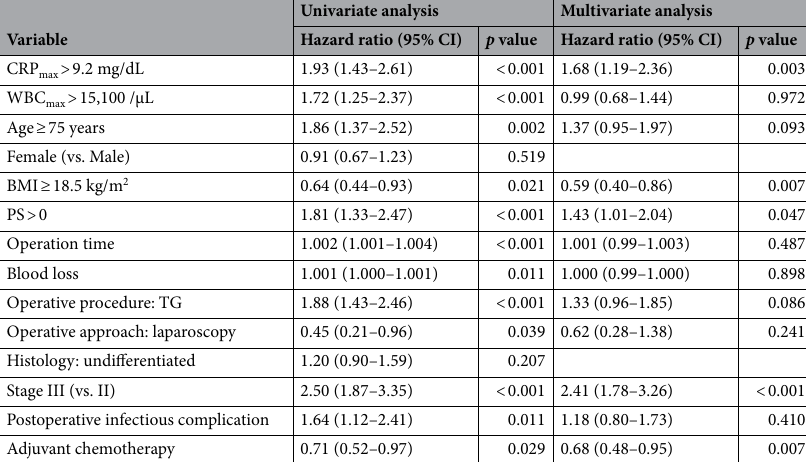
Table 2. Univariate and multivariate analysis for overall